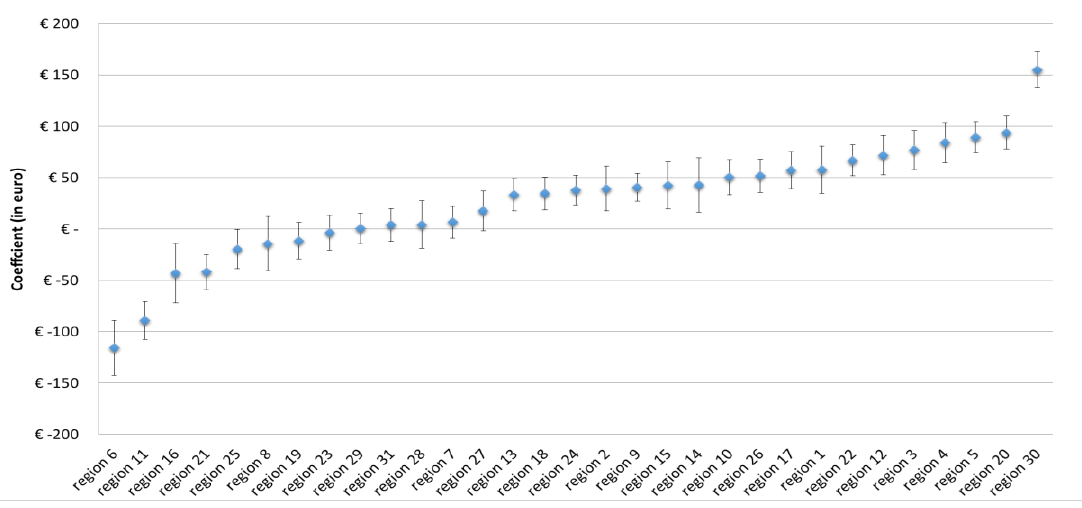
Figure 4.1: Linear regression model for the average intensity of care 65 and older